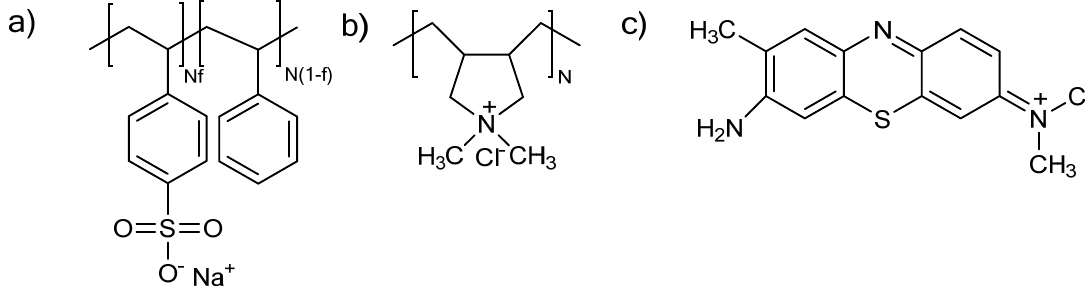
Figure 1. Two-step mechanism of PEC particle formation. The morphology of the secondary complexes depends on the hydrophobicity of the PEs, with highly hydrophobic PEs favoring a raspberry-shaped morphology and hydrophilic PEs leading to a more homogeneous structure (adapted from [16]). For solid-like complexes, the formation of PEC particles is generally described by a two-step mechanism, which consists in the formation of primary PEC particles, followed